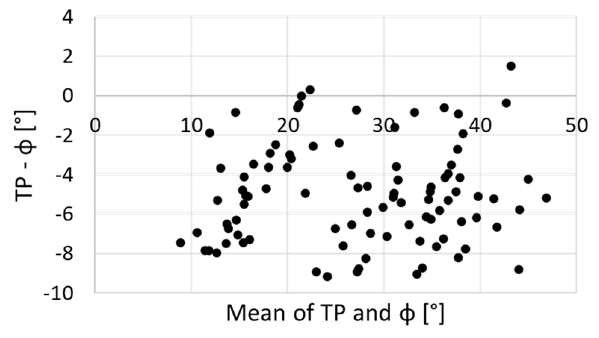
Figure 4. Bland–Altman plot for visually inspecting the presence of heteroscedasticity (i.e., linear trend) in the dataset. The plot depicts the differences (error) between the angle of the thorax relative to the pelvis (TP) and φ against the respective means.